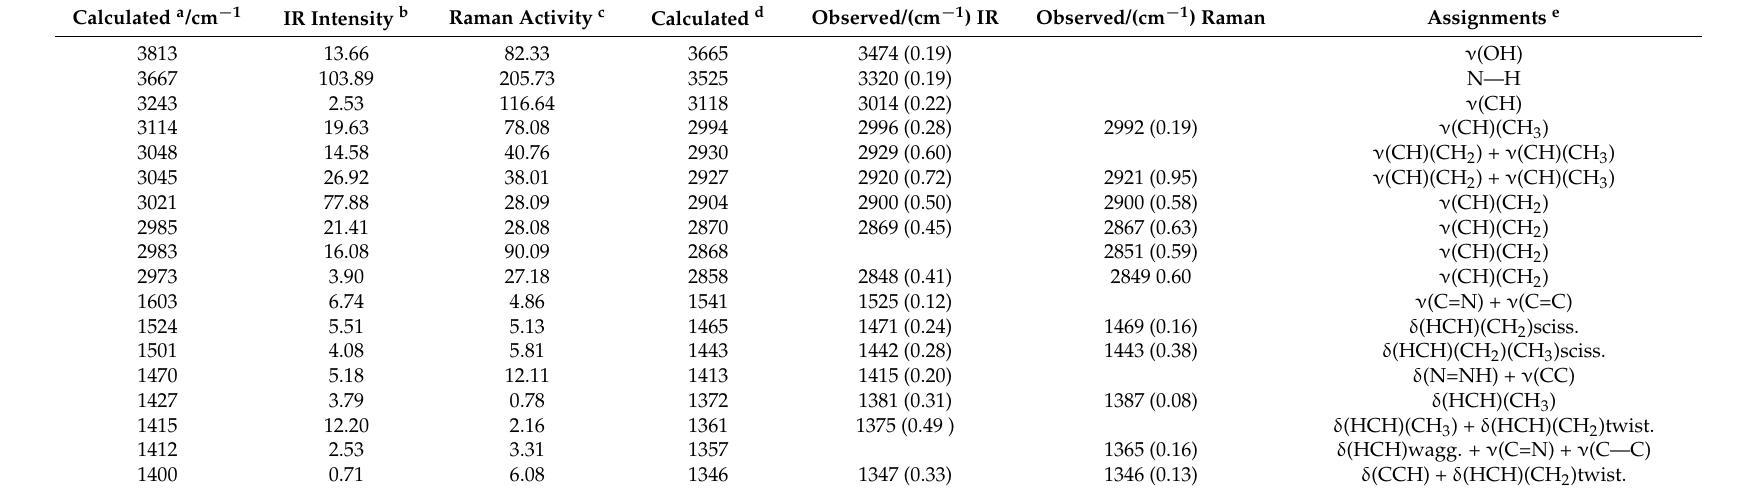
Table 2. Wavenumbers (cm − 1 ) of observed and calculated bands in the infrared and Raman spectra of